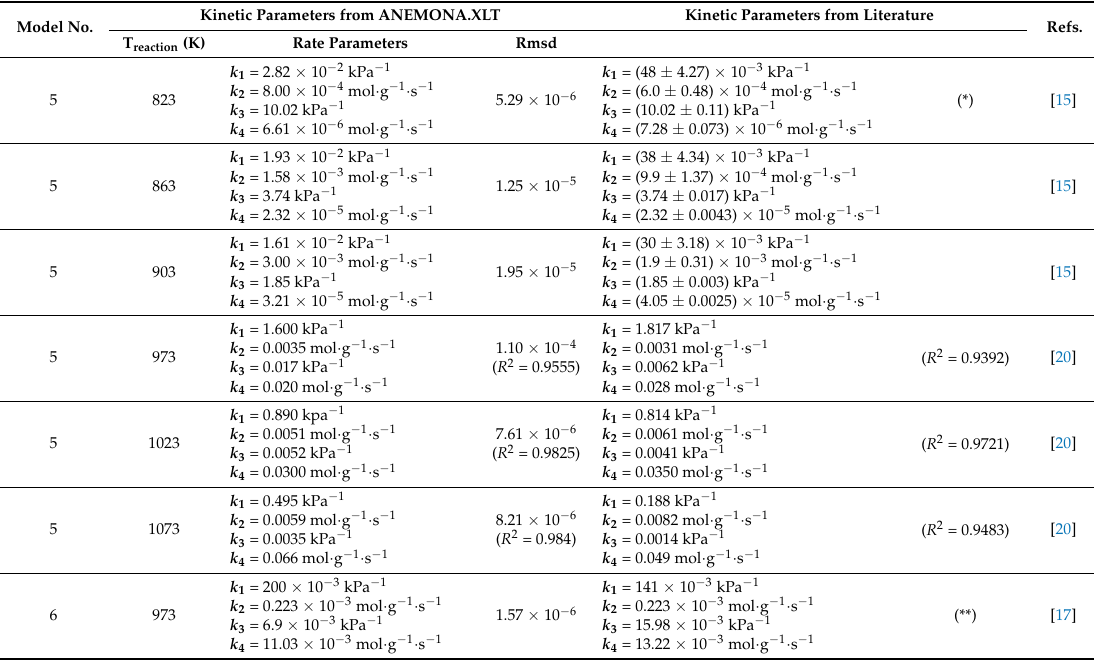
Table 2. Model parameters predicted by ANEMONA.XLT template from Models 5 and 6. Model